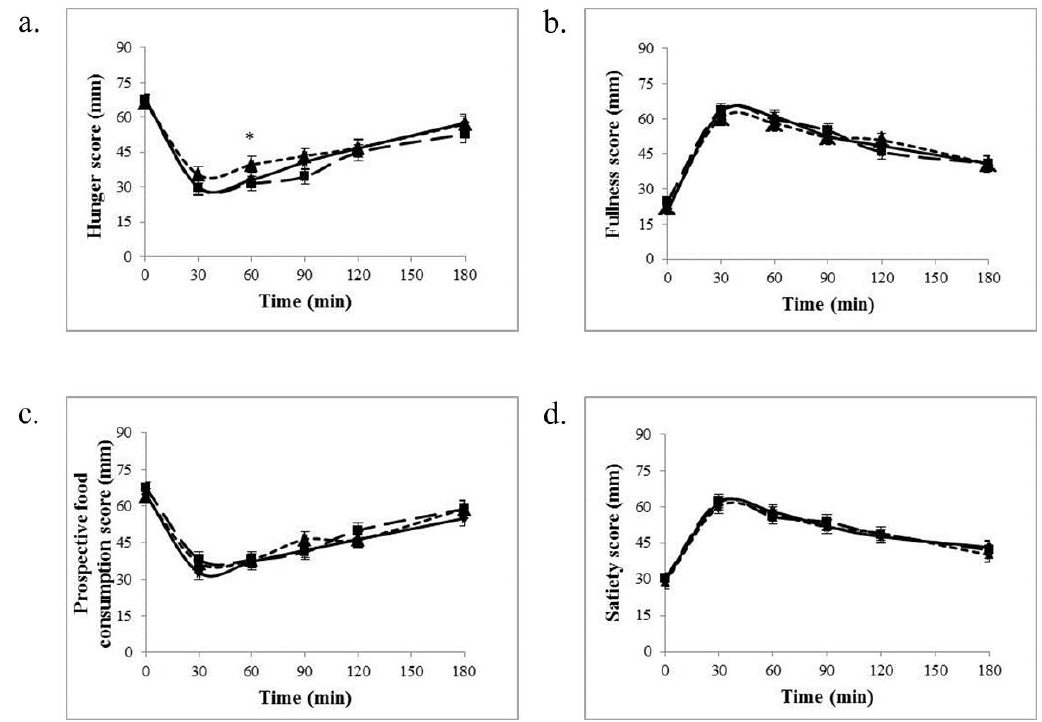
Figure 2. Visual analogue scales (VAS) scores for hunger ( a ), fullness ( b ), satiety ( c ), and prospective food consumption ( d ) during 3 h after the mixed breakfast meal with a dose of Salacia Chinensis (SC) or placebo ( n = 48). * p < 0.05, Differs compared to placebo. Values are means ± standard error of the mean (SEM). Placebo: ; 300 mg: ; 500 mg: .